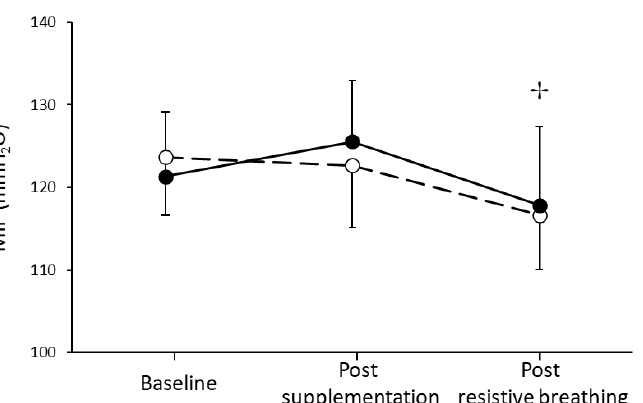
Figure 2. Maximal inspiratory pressure (MIP) at baseline, one hour post L-citrulline (closed circles) and placebo (open circles) supplementation and post resistive breathing to task failure. ( ✢ ) indicates significant main effect of time ( p < 0.05). Additionally, during the last stage of the incremental resistive breathing (i.e., 90% of the maximal MIP), the number of breaths at task failure was not different between the L- citrulline and the placebo conditions (i.e., 41 ± 16 and 36 ± 15 number of breaths, respec- tively; p = 0.404).